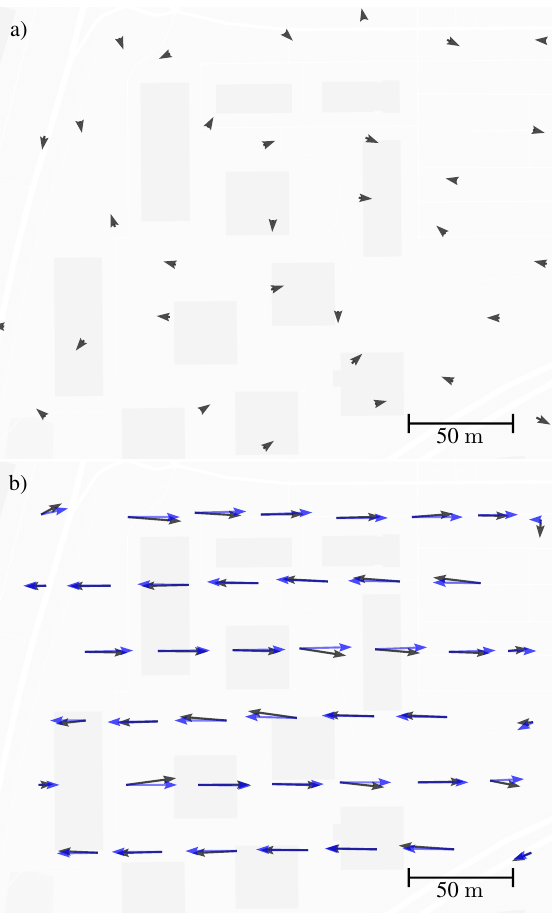
Figure 6: Motion of the drone during the acquisition of the im- ages as estimated by the rolling shutter model. Each arrow repre- sents a picture. The length of the arrows is proportional to the motion of the drone during the readout time and upscaled for readability. The motions as estimated from the on-board drone measurements and from the rolling shutter model are displayed in blue and black respectively. (a) Results for the eBee dataset with a global shutter camera show very small estimated displace- ments in random directions. (b) Results for the Phantom 2 Vi- sion+ dataset at 8m / s